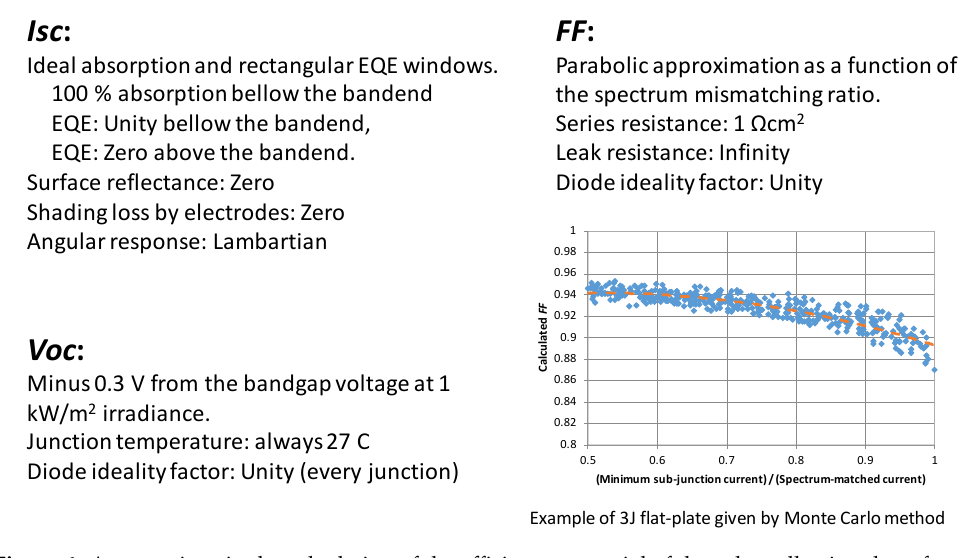
Figure 4. Assumptions in the calculation of the efficiency potential of the solar cell using three factors.